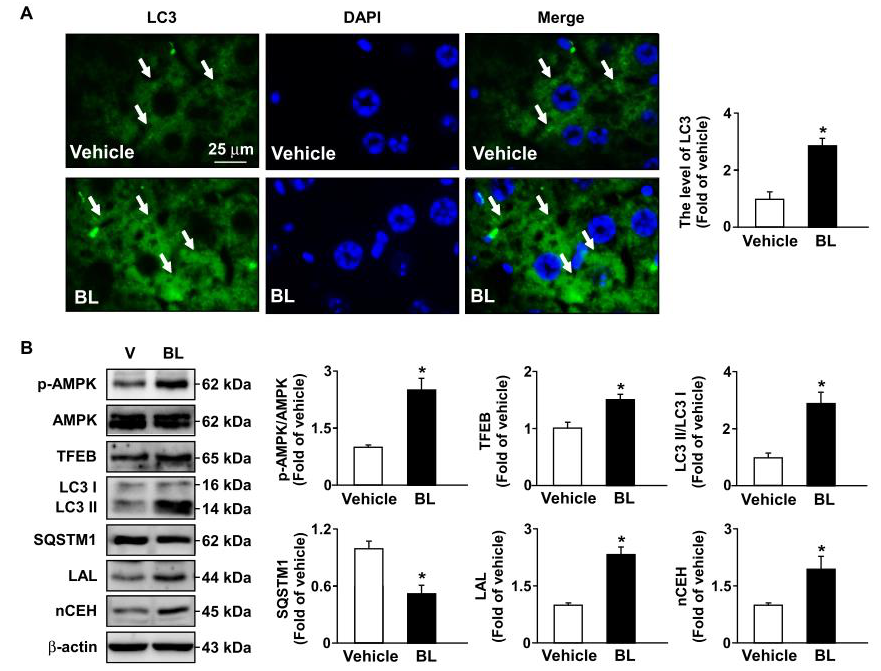
Figure 5. Bromelain triggers autophagy in the livers of apoe −/− mice . Male apoe −/− mice were orally administered bromelain (BL, 20 mg/kg/day) or vehicle (PBS) for four weeks. ( A ) Immunostaining with anti-LC3 antibody in the livers of bromelain- or vehicle-treated apoe −/− mice. Scale bar = 25 μ m. The hepatocytes with LC3 positive signals were indicated by arrows. ( B ) Western blot analysis of p-AMPK, AMPK, TFEB, LC3, SQSTM1, LAL, nCEH, and β -actin. * p < 0.05 vs. vehicle-treated apoe −/− mice.